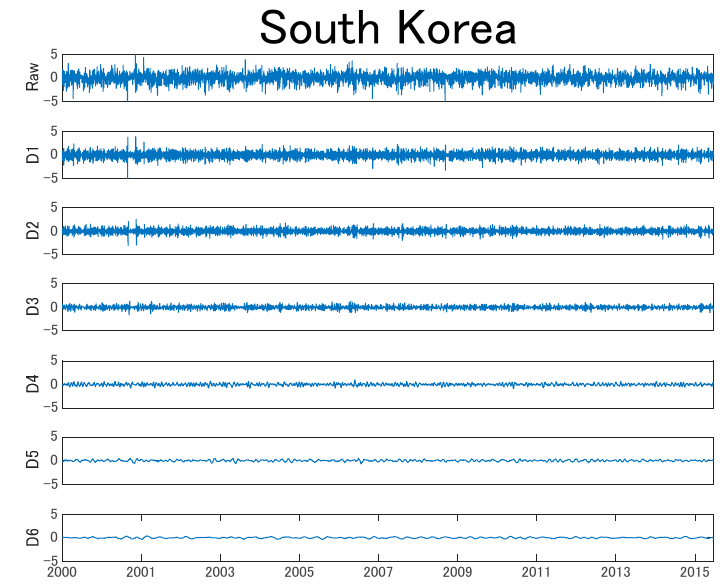
Figure 2. Wavelet decomposition of standardized residuals for crude oil and East Asian stock markets. Raw represents the original time series. D1 (two days) and D2 (four days) represent the short-term fluctuations. D3 (eight days) and D4 (16 days) represent for the mid-term. D5 (32 days) and D6 (64 days) represent for the long term.